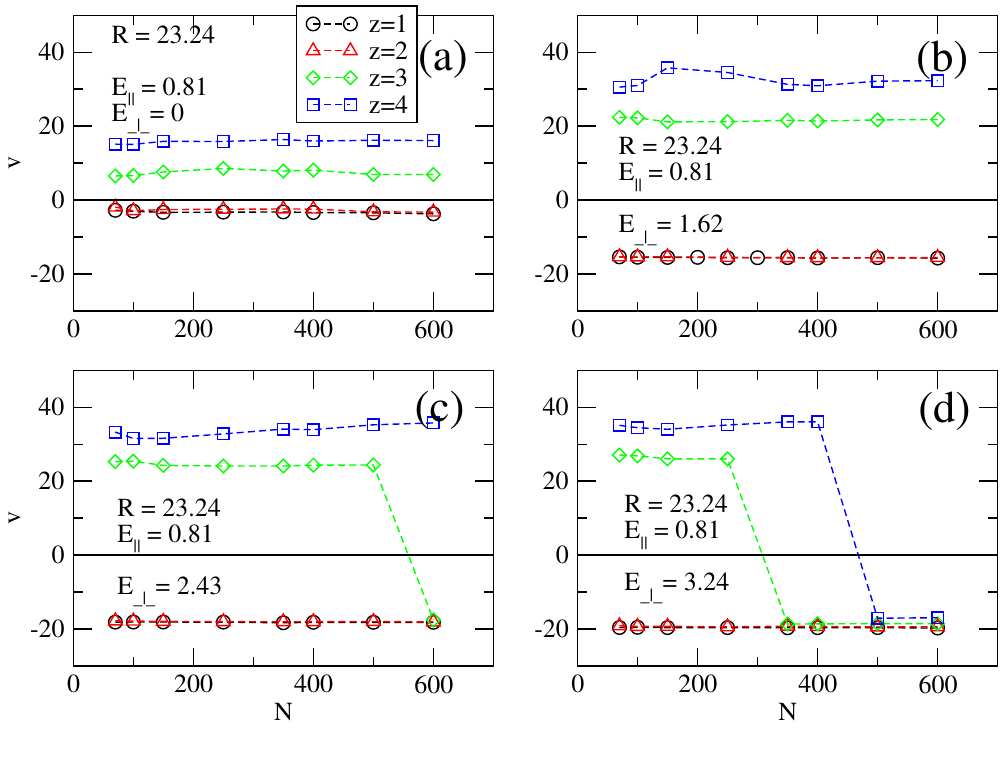
Figure 5. Graphs similar to Figures 2–4 for the largest cylinder of radius R = 23 . 24